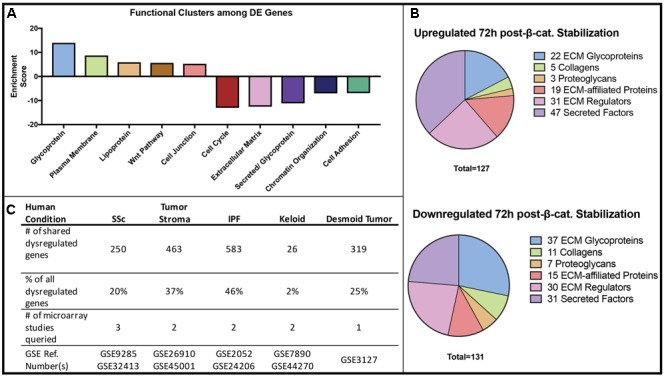
Gene Ontology and disease comparison analysis of all β-catenin responsive genes. (A) The functional annotation (DAVID) of differentially expressed (DE) genes in β-catenin stabilized GOF. (B) A defined matrisome gene dataset (Naba et al., 2012) overlapped with differentially expressed genes in GOF yielded 127 up-regulated and 131 down-regulated matrisome genes consisting of ECM glycoproteins, secreted factors and ECM-regulators. (C) Differentially expressed genes in GOF dataset are also dysregulated in a variety of human fibrotic conditions.